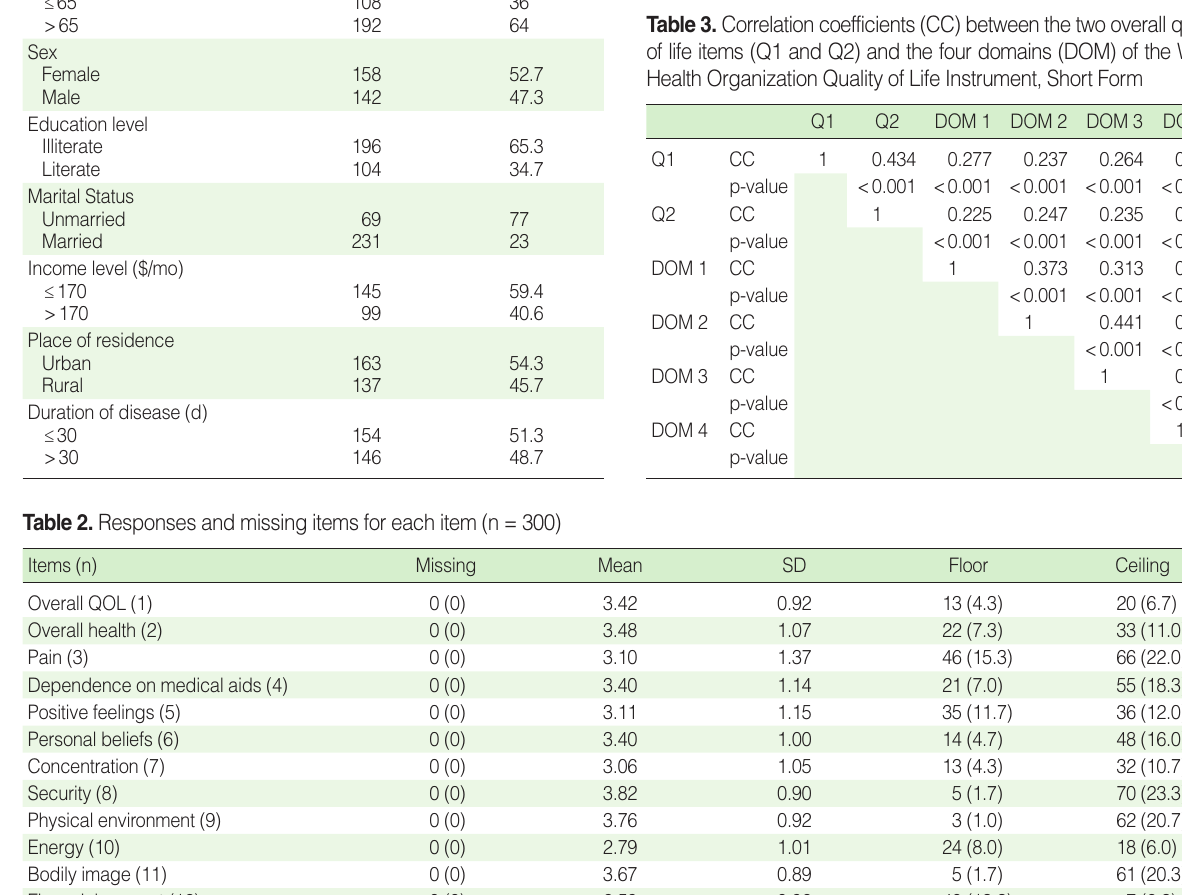
Table 3. Correlation coefficients (CC) between the two overall